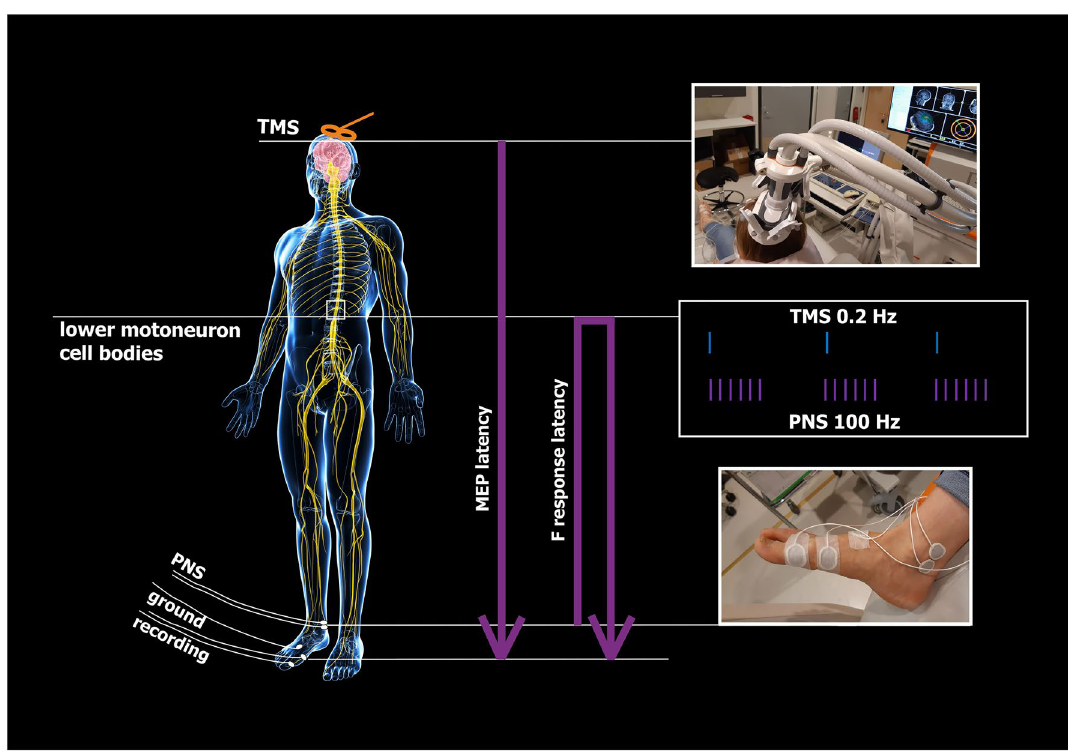
Figure 2. Schematic representation of high-PAS setup. Upper motor neurons are activated by transcranial magnetic stimulation (TMS, represented as an orange-coloured coil, see also photograph of the coil and navigation system on the right). Lower motor neurons are activated by peripheral nerve stimulation (PNS, here stimulation electrodes are located behind the medial malleolus to activate tibial nerve, see also photograph on the right). Recording electrodes are placed at the abductor hallucis (AH) muscle belly and are used for F-response and motor-evoked potential (MEP) latency recordings. F-wave latency and motor evoked potential (MEP) latency are measured before the PAS session to calculate the interval between TMS and PNS with the formula [interstimulus interval (ISI) = F latency − MEP latency ] as described before in Refs. 5,6 . During PAS, TMS pulses arrive every 5th second to corticomotoneuronal synapses, coinciding with the first pulse of the 100 Hz-PNS train. See Refs. 5,6,13 for more figures and a detailed description of the high-PAS setup.